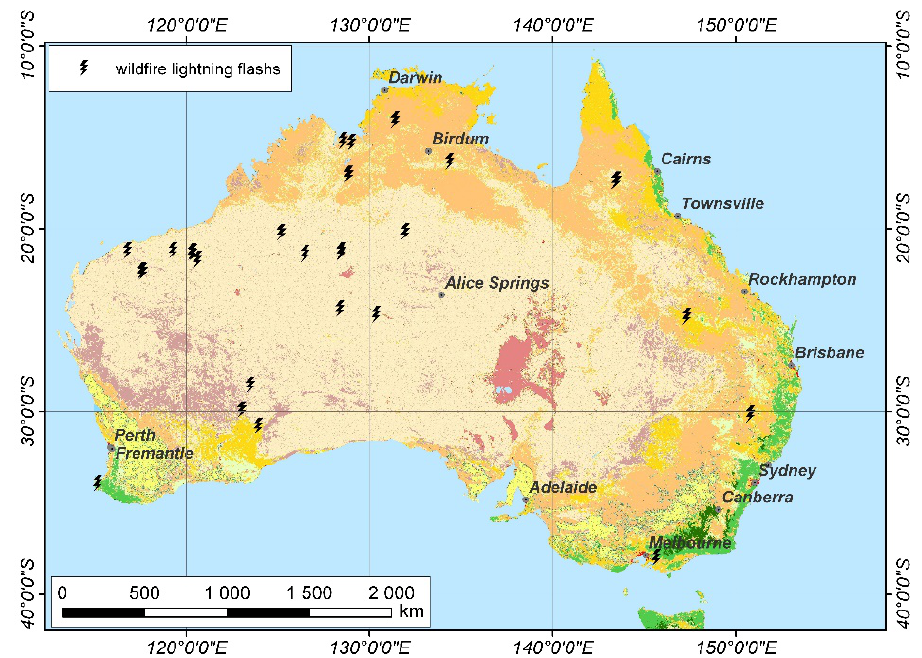
Figure 9. The spatial distribution of the ISS LIS lightning flashes, which can be triggers for lightning-caused ignitions, is presented (see Table 3). The MODIS land cover map (MCD12Q1, 2018) is used as a background image. Table 4. Numbers of lightning wildfires in Australia in 2017–2020, occurring in the IGBP land cover vegetation classes. The values in brackets are related to events which did not complete the re- quirements for selection, specified in Section 2.5.